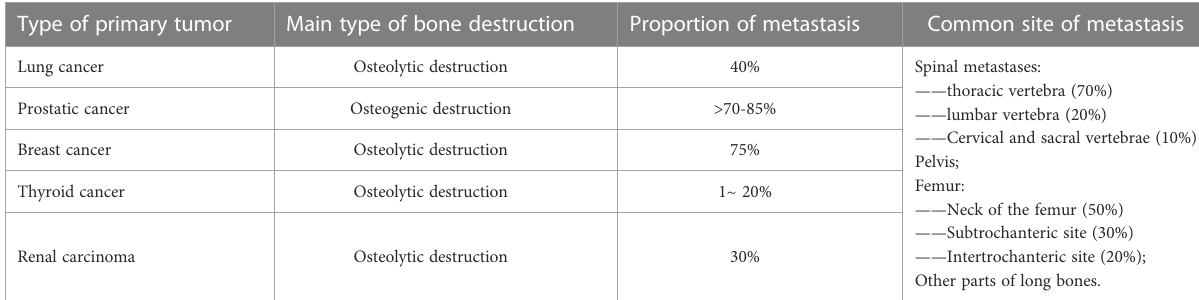
TABLE 1 A summary of the types of bone destruction, occurrence probability and common sites of bone